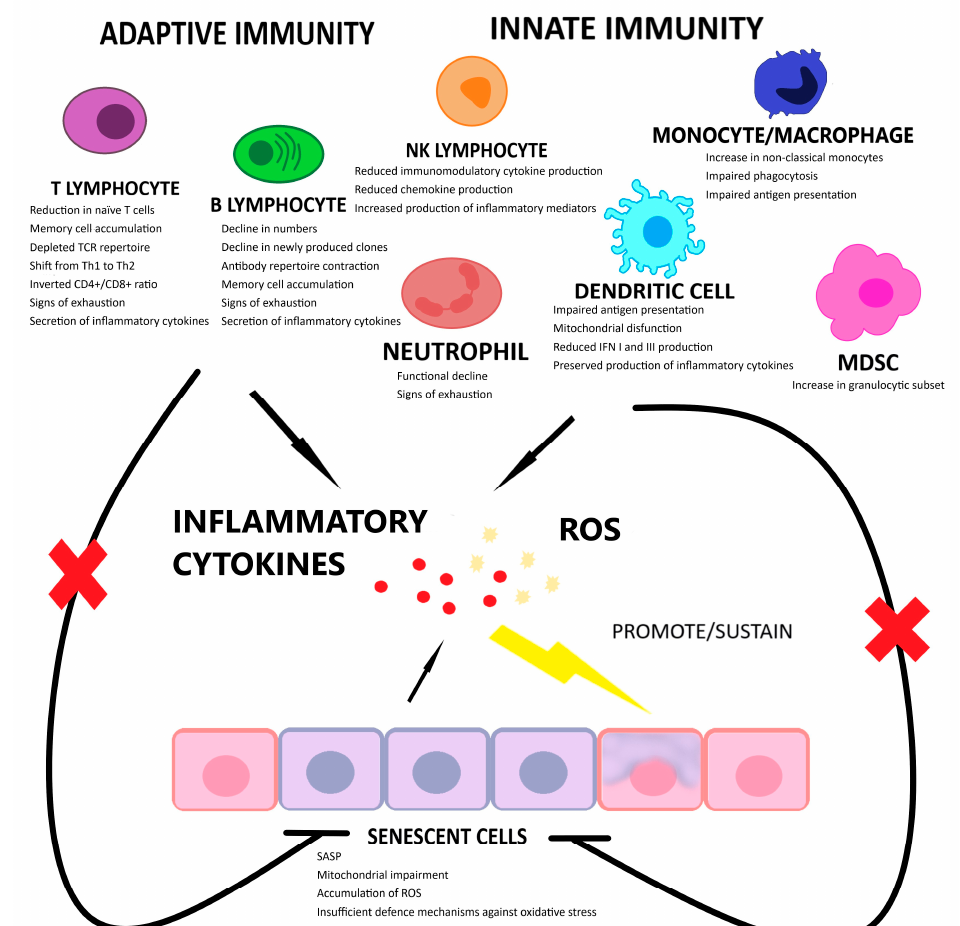
Figure 1. Schematic representation of immunosenescence and senescence triggering and supporting inflammaging. The inability of senescent cells to cope with an age-dependent increased burden of oxidative stress determines the accumulation of ROS and the release of inflammatory mediators that create the conditions for a further expansion of the senescent population. At the same time, immunosenescence determines an increase in both extracellular inflammatory mediators and a reduction in immune cell ability to clear senescent cells. The combination of these events leads to/supports inflammaging. TCR, T cell receptor; IFN, interferon; MDSC, myeloid derived suppressor cell; ROS, reactive oxygen species.This image was realized with Microsoft Paint 3D (Microsoft Corporation, Redmond, WA, USA).